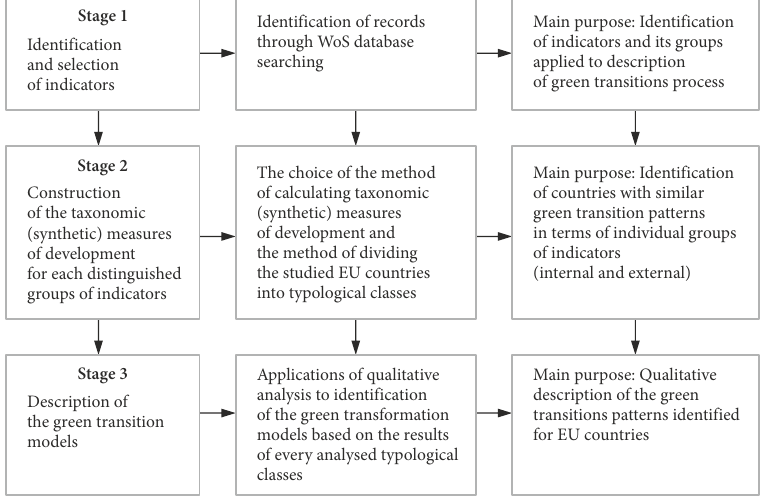
Figure 1. Research procedure